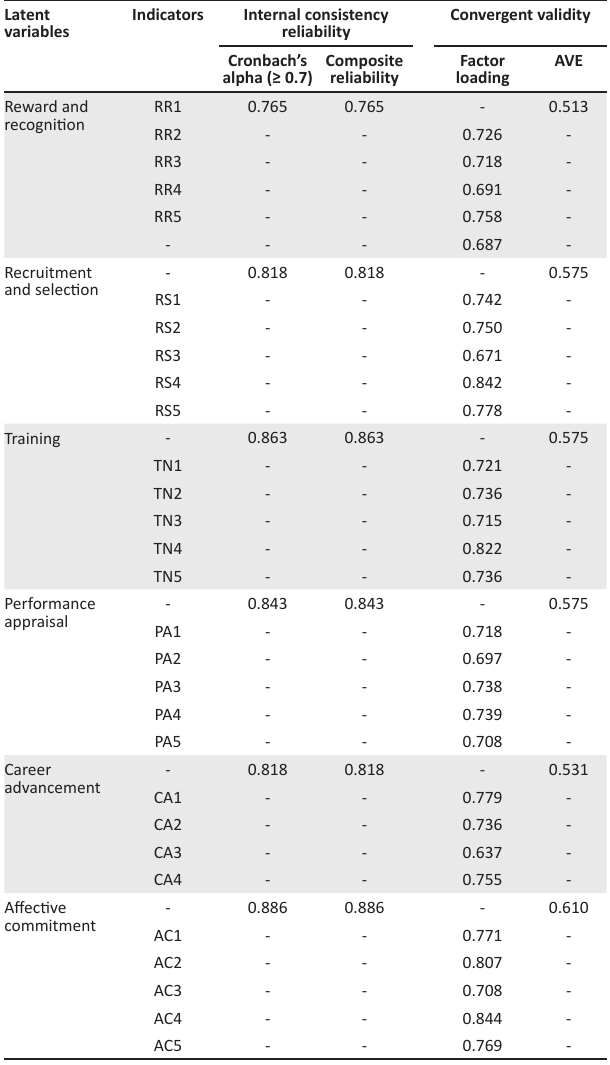
TABLE 2: Result summary for reflective measurement model.